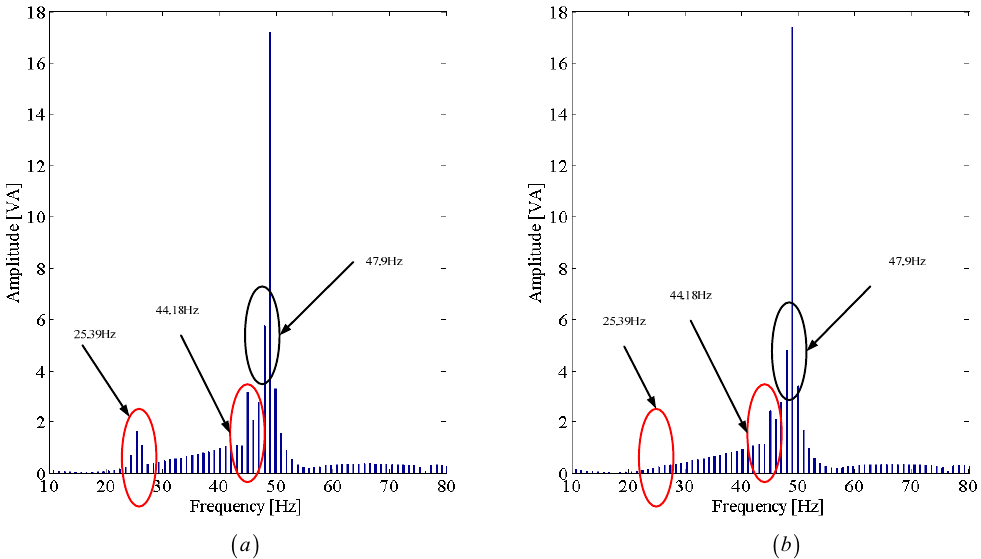
Figure 13. The comparison results between the simple use of WPD and the proposed method around the frequency of 2 f r : ( a ) WPD method, ( b ) proposed method (under 33% of rated load with 2% of purely DE).